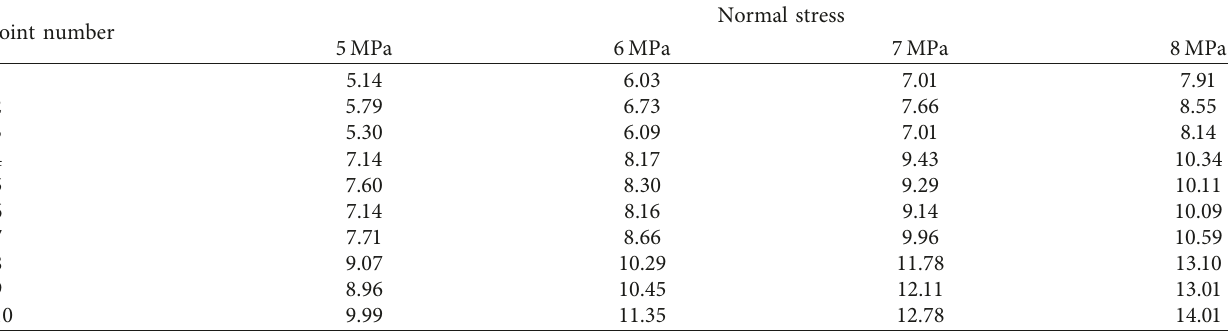
Table 7: τ RL values of 10 standard joint